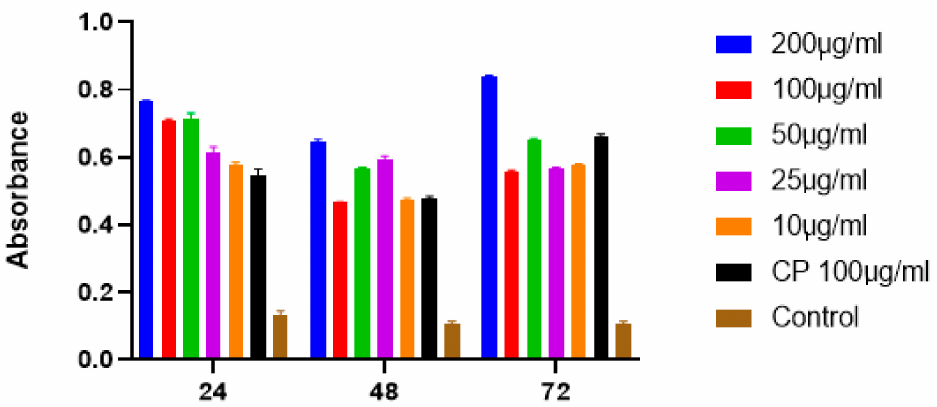
Figure 7. The graphs showing the results of one-way ANOVA analysis of SFCP on MCF-7 cell lines at 24, 48, and 72